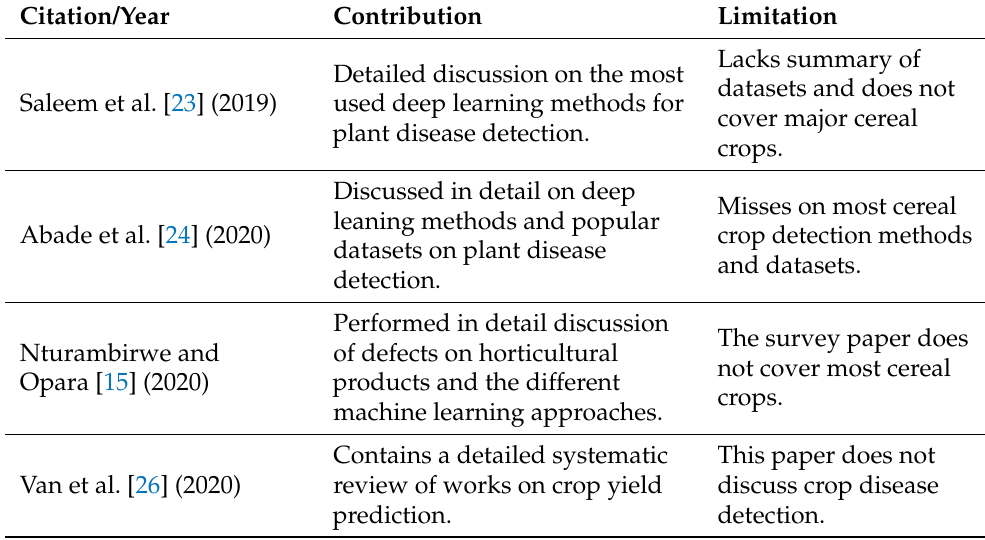
Table 1. Summary.